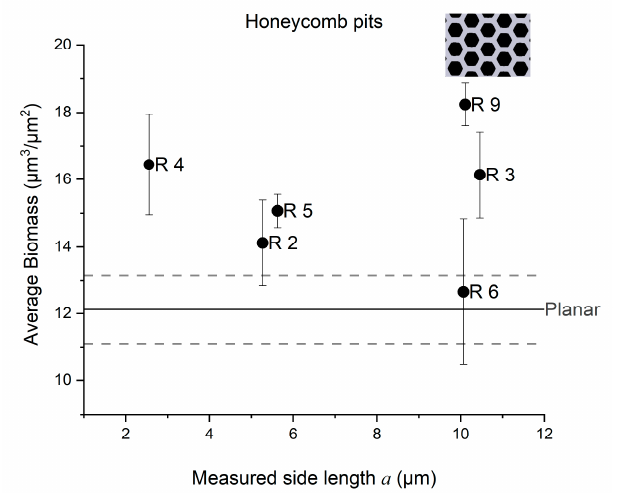
Figure 5. Average bacterial biofilm biomass ( µ m 3 µ m − 2 ) (bacterial volume/surface area) of Phaeobac- ter inhibens biofilm on the different pit surfaces, as a function of side length 𝑎 . The straight line serves as a baseline, as it indicates the average biomass on the planar surface, with the standard deviation for the planar surface shown with dashed lines. Data are depicted as mean + SD (n = 3).